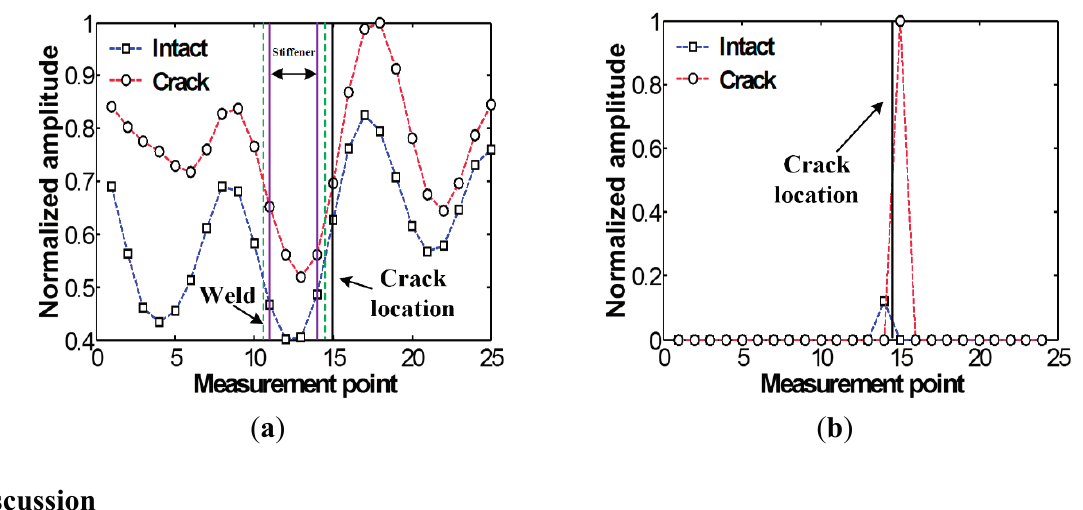
Figure 6. Spatial energy variations obtained from the intact and cracked areas of the specimen: ( a ) Filtered energy distributions and ( b ) the corresponding energy variations after spatial derivative and employing a threshold value.